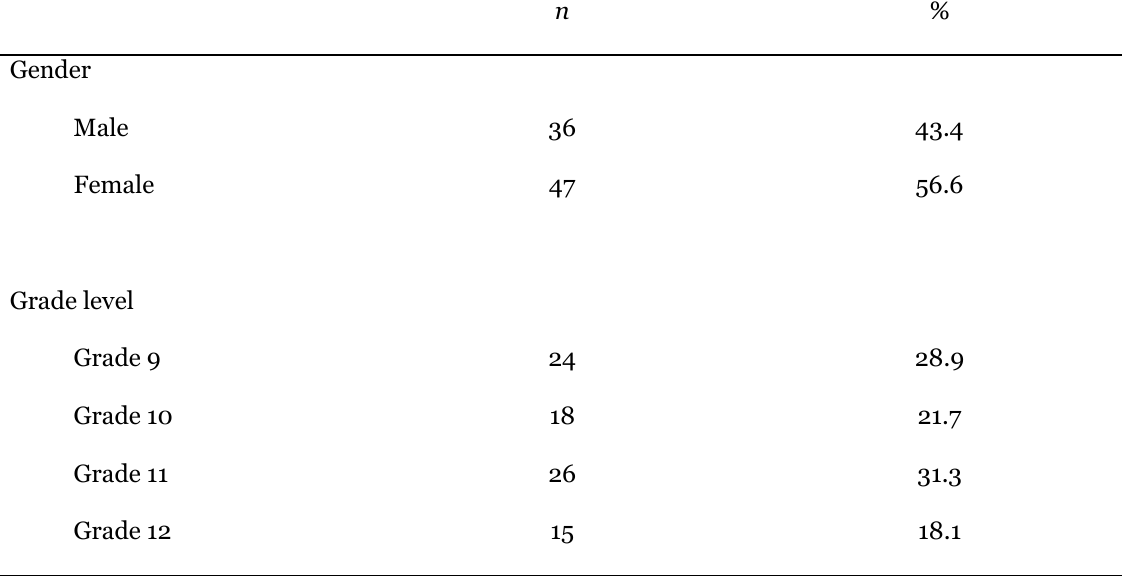
Individual and School Characteristics of Third Study Group